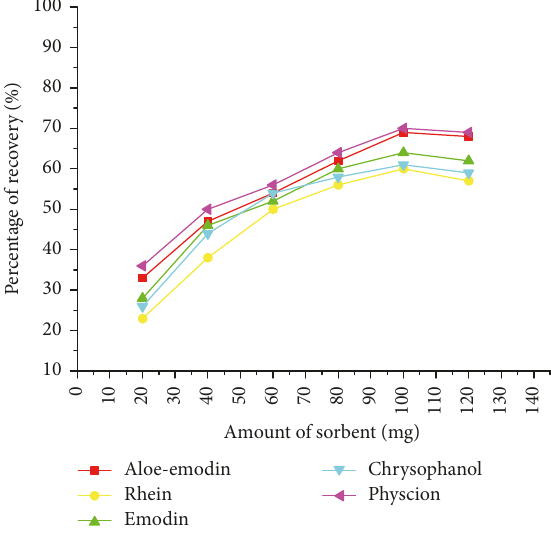
Figure 4: Effect of BTO-SPE sorbent amount on the recovery of